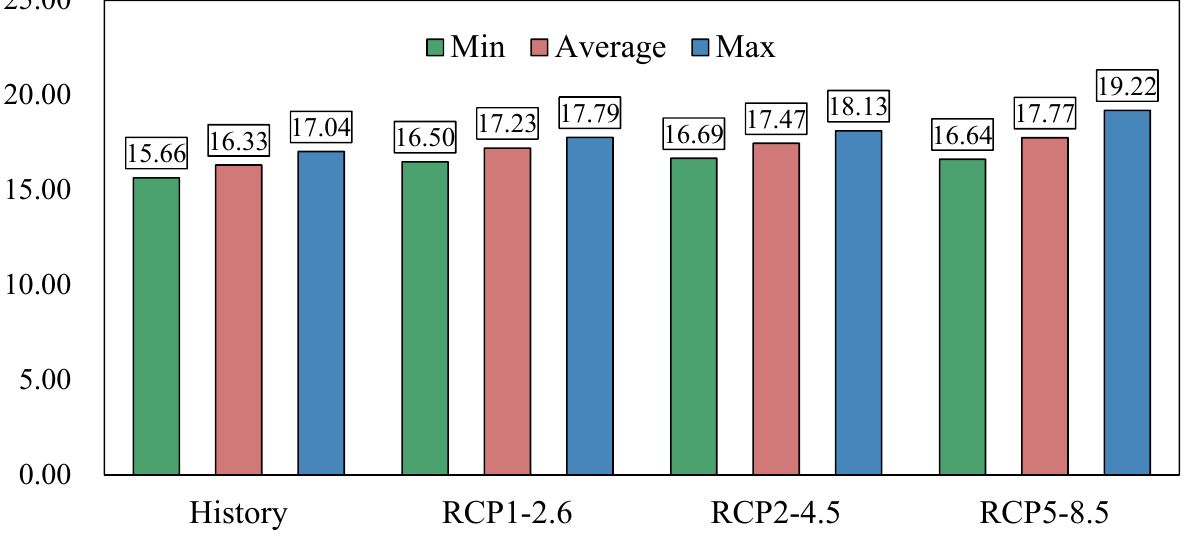
Figure 3. Average and extreme values of surface water temperature in Dianchi Lake.